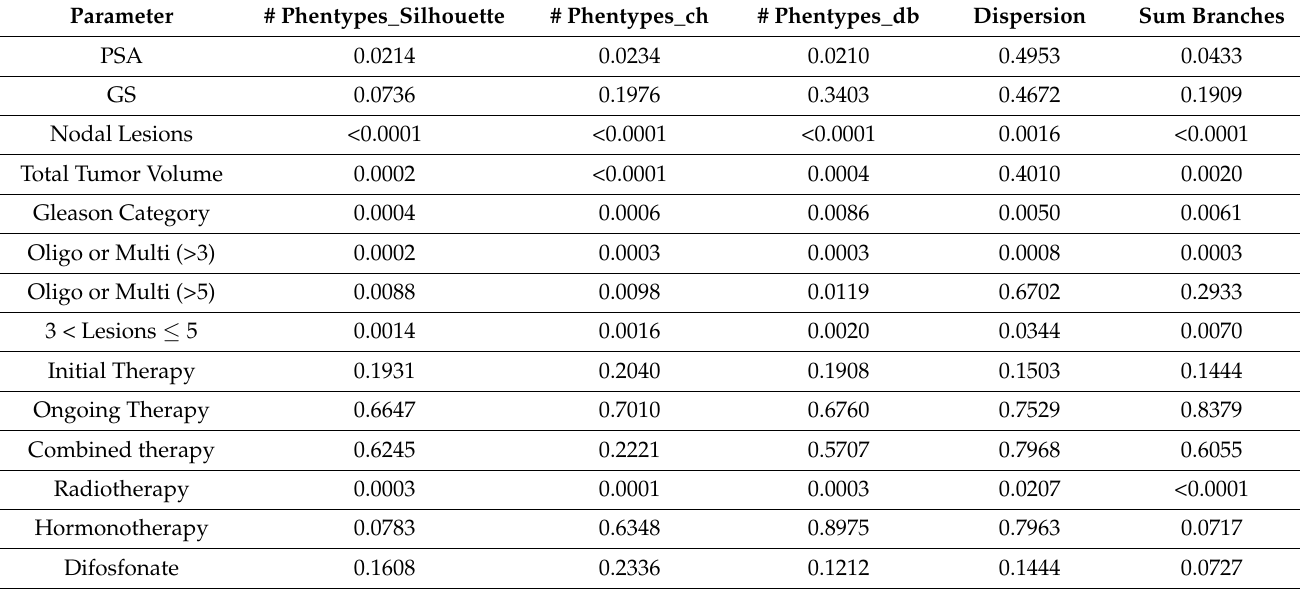
Table 4. Discrimination power of the number of phenotypes, number of lesions, sum of tree branch lengths, and lesions’ radiomic dispersion in stratifying patients according to type of therapy, number of therapies, oligo/multi-metastatic status, Gleason score, PSA, and response to therapy ( p -values). The number of phenotypes has been computed according to Silhouette coefficient (#